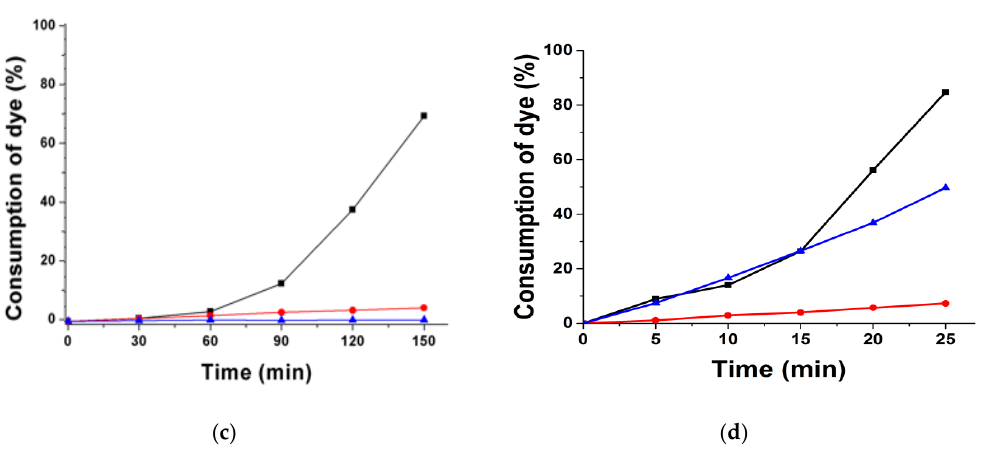
Figure 6. Consumption of dyes vs. irradiation time upon irradiation with a LED@405 nm ( a ) dye 5 /Iod/amine( ); dye 5 /Iod(●); dye 5/ amine( ). ( b ) dye 9 /Iod/amine( ); dye 9 /Iod(●); dye 9 /amine( ). ( c ) dye 17 /Iod/amine( ); dye 17 /Iod(●); dye 17 /amine( ). ( d ) dye 19/ Iod/amine( ); dye 19 /Iod(●); dye 19 /amine( ).